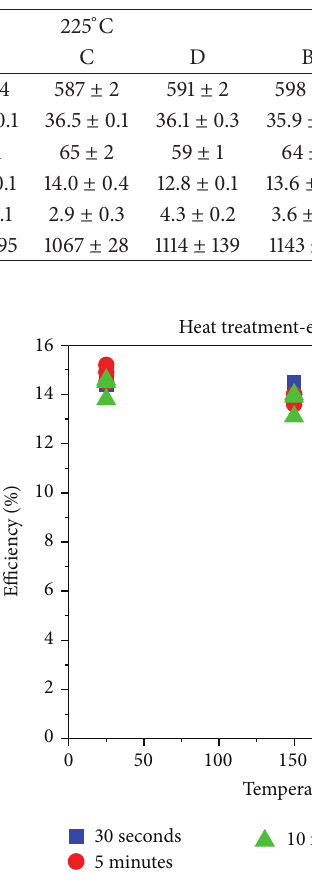
Figure 3: Efficiency evolution for different heat treatment condi- tion. The 30 seconds (in blue), the 300 seconds (in red), and the 600 seconds (in